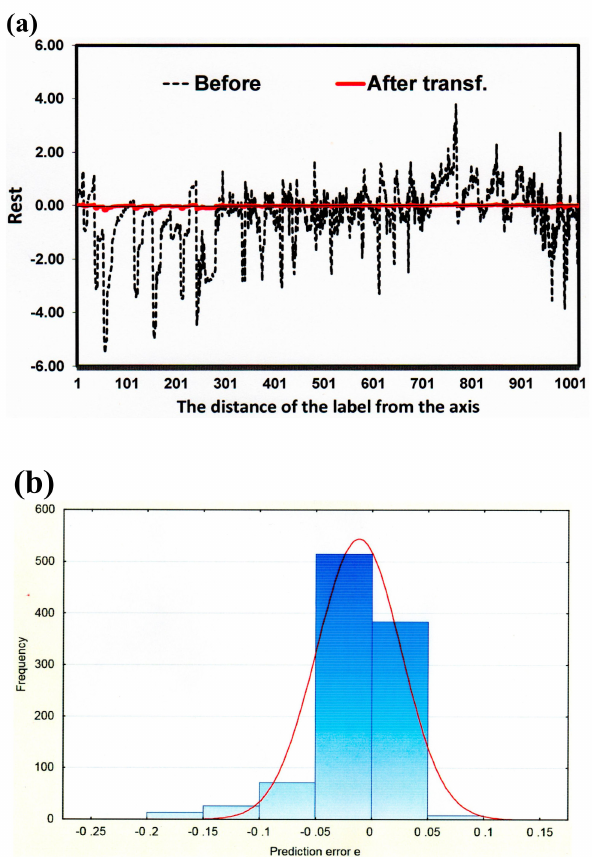
Figure 7. Profile of values: ( a ) before and after transformation; ( b ) histogram of the prediction error = (cid:104) (cid:104) p (cid:105)(cid:105) (cid:16) p (cid:17) − u ε = γ − k × log − k × log − k 0 0 1 σ 64 × γ 2 3 1 p 1 w atm